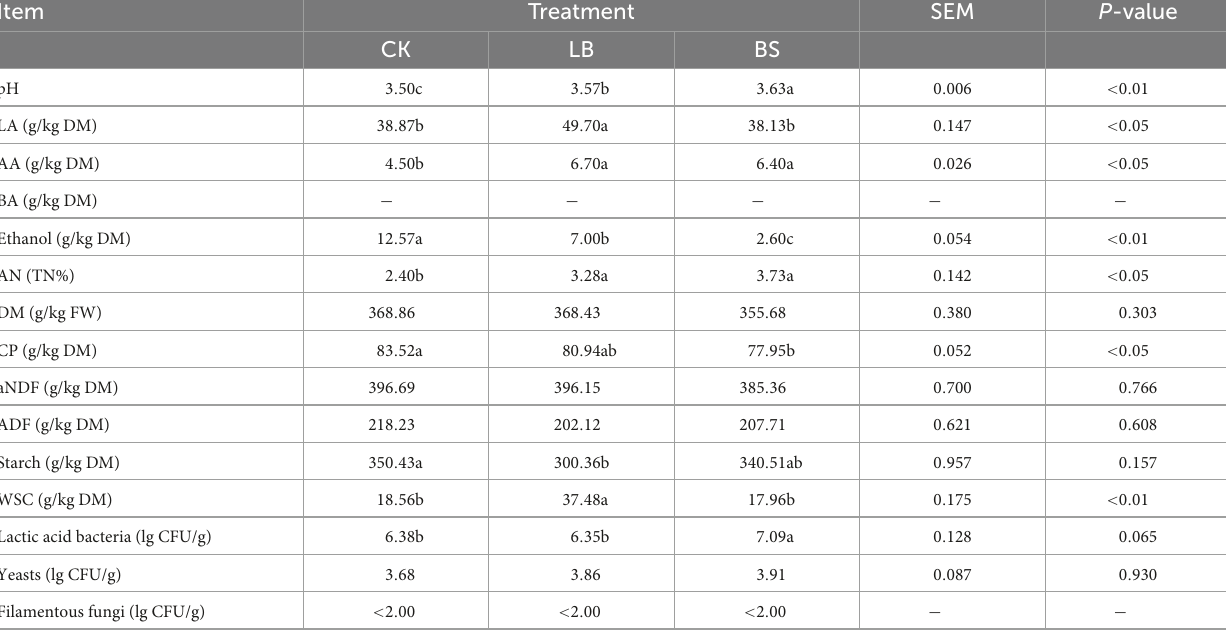
TABLE 2 Fermentation quality, nutrient composition and microbial counts of whole plant corn silage after 42 days of ensiling. Item Treatment SEM P -value